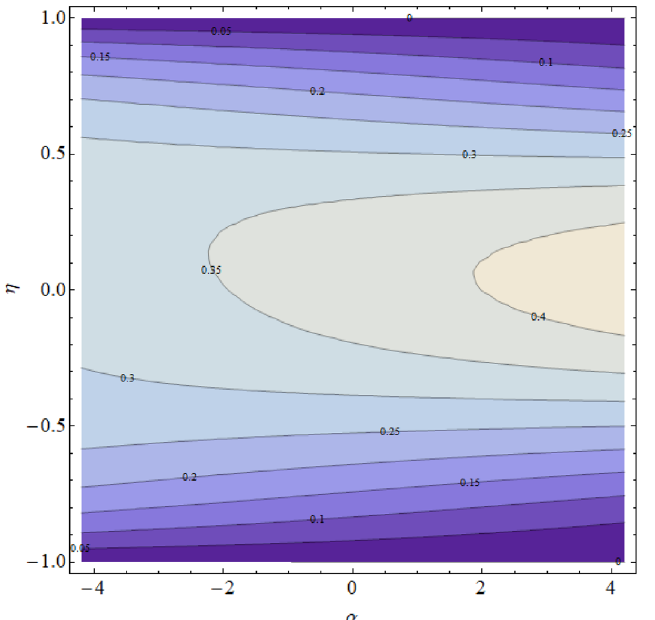
Figure 12. Contour upshot due to the variation in α .